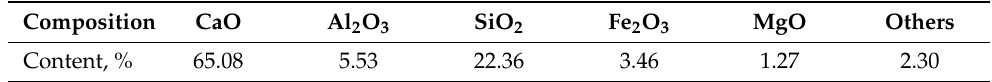
Table 2. Main chemical composition of